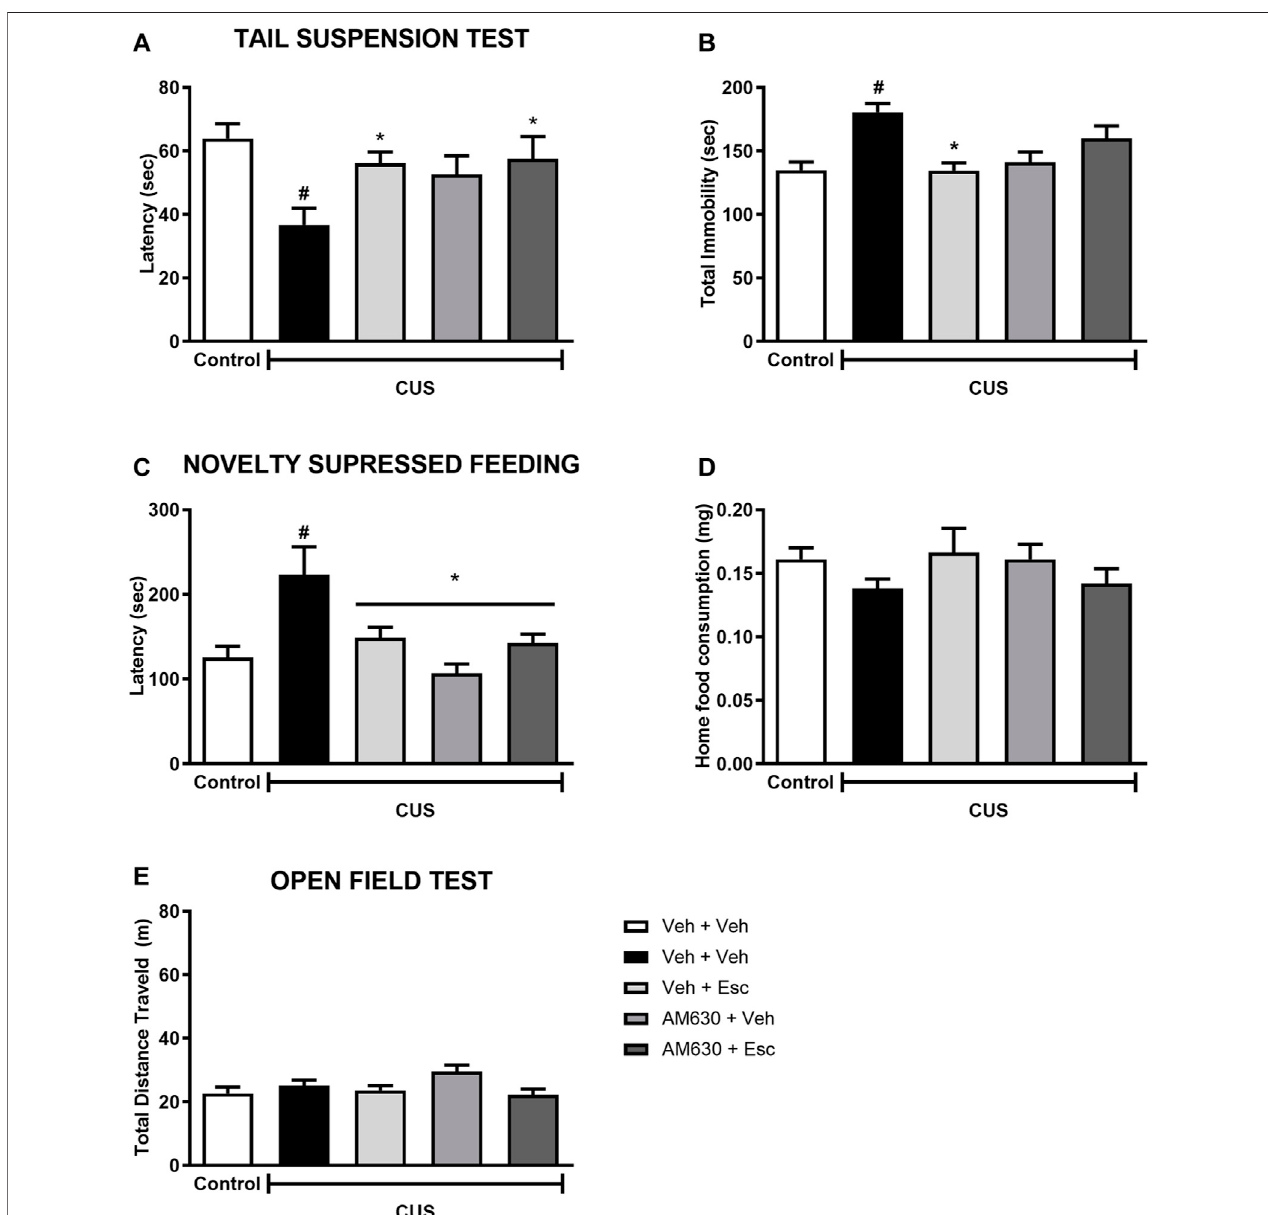
FIGURE 3 | AM630 interferes with the behavioral effects of escitalopram. Figure shows the fi rst immobility episode time in the TST in seconds (A) , the total time of immobility in the TST in seconds (B) , the latency for fi rst episode of food ingestion in NSF in seconds (C) , the total food ingestion in the home cage (D) , and the total distance traveled, in meters, by animals submitted to CUS protocol (E) . Groups were: non-stressed/saline/saline ( n (cid:1) 10); CUS/Veh + Veh ( n (cid:1) 10); CUS/AM630 + Veh ( n (cid:1) 10); CUS/Veh + Esc ( n (cid:1) 9); and CUS/AM630/Esc ( n (cid:1) 10). ANOVA-TWO WAY was employed and differences were considered statistically signi fi cant when p < 0.05 (# relative to NS/Veh + Veh and * relative to CUS/Veh + Veh).